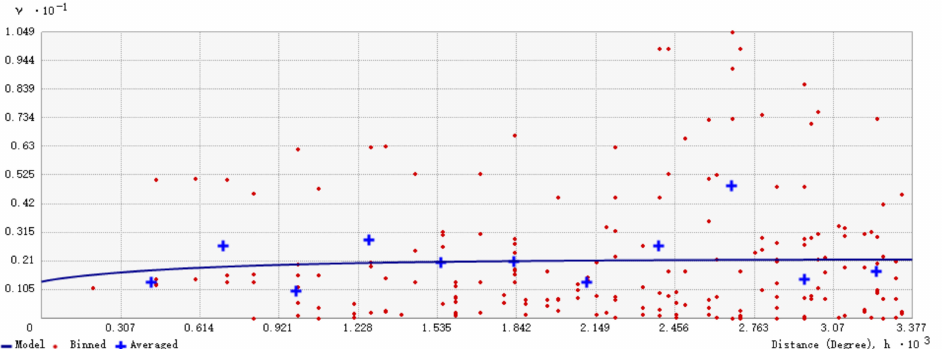
Figure 7. Semi-variograms computed for soil organic carbon from the predicted dataset of bare soils in the western Guanzhong Plain, China.